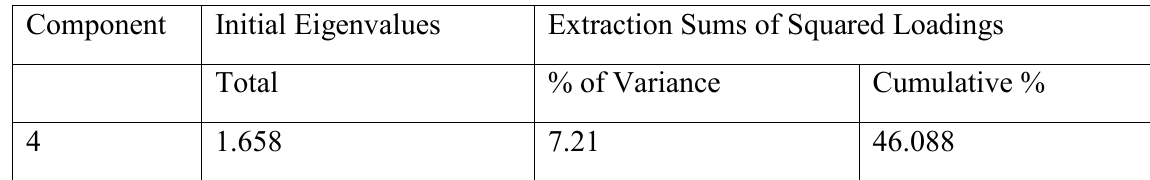
Table 1.29: Variance explained for Adaptive Resilience